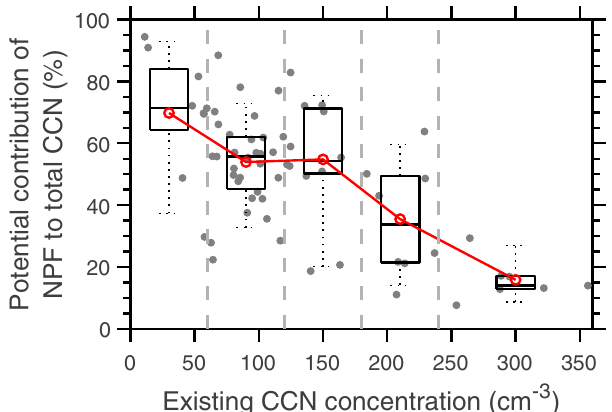
Fig. 4 Potential contribution of marine boundary layer new particle formation (NPF) to cloud condensation nuclei (CCN) population as a function of existing CCN concentration. The contribution is calculated as the concentration ratio of CCN originating from new particles formed in the marine boundary layer (i.e., NPF CCN) to total CCN for the 67 events observed at the Eastern North Atlantic (ENA) site. NPF CCN represents the nucleation mode particles that survived coagulation scavenging until reaching the CCN size (i.e., 80 nm), and total CCN is the sum of existing CCN and NPF CCN. The gray dots represent the results for individual events, and the dashed gray lines indicate the boundaries (i.e., 60, 120, 180, and 240 cm − 3 ) between existing CCN concentration bins. The numbers of events in the fi ve existing CCN concentration bins are 9, 31, 12, 8, and 7 from low to high concentration, respectively. The box-whisker plot is drawn for 10-, 25-, 50-, 75-, and 90-percentiles. The red circles represent the mean values. Source data are provided as a Source Data fi